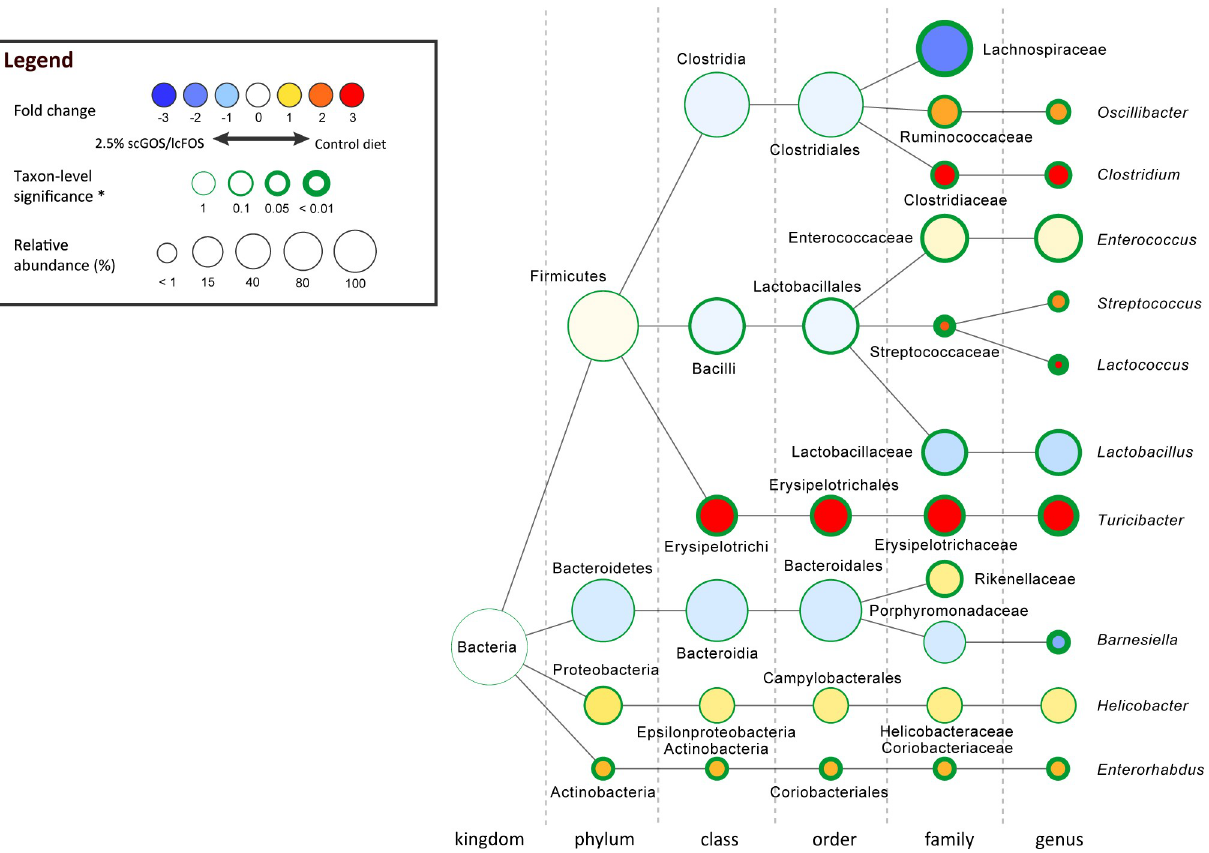
Fig 1. Prebiotic diet containing scGOS/lcFOS significantly alters the composition of intestinal microbiota of IL-1Ra -/- mice. Phylogenetic tree created by Cytoscape software showing specific changes in intestinal microbial community at different taxonomic levels in the mice fed 2.5% scGOS/ lcFOS diet compared to mice fed a control diet. Nodes represent taxa, and the size of each node represents its relative abundance. The color blue indicates an increase in the 2.5% scGOS/lcFOS fed mice compared to control mice, while the color red indicates an decrease in the 2.5% scGOS/lcFOS fed mice. The thickness of the green border indicates the degree of statistical significance by Mann-Whitney U test, uncorrected.